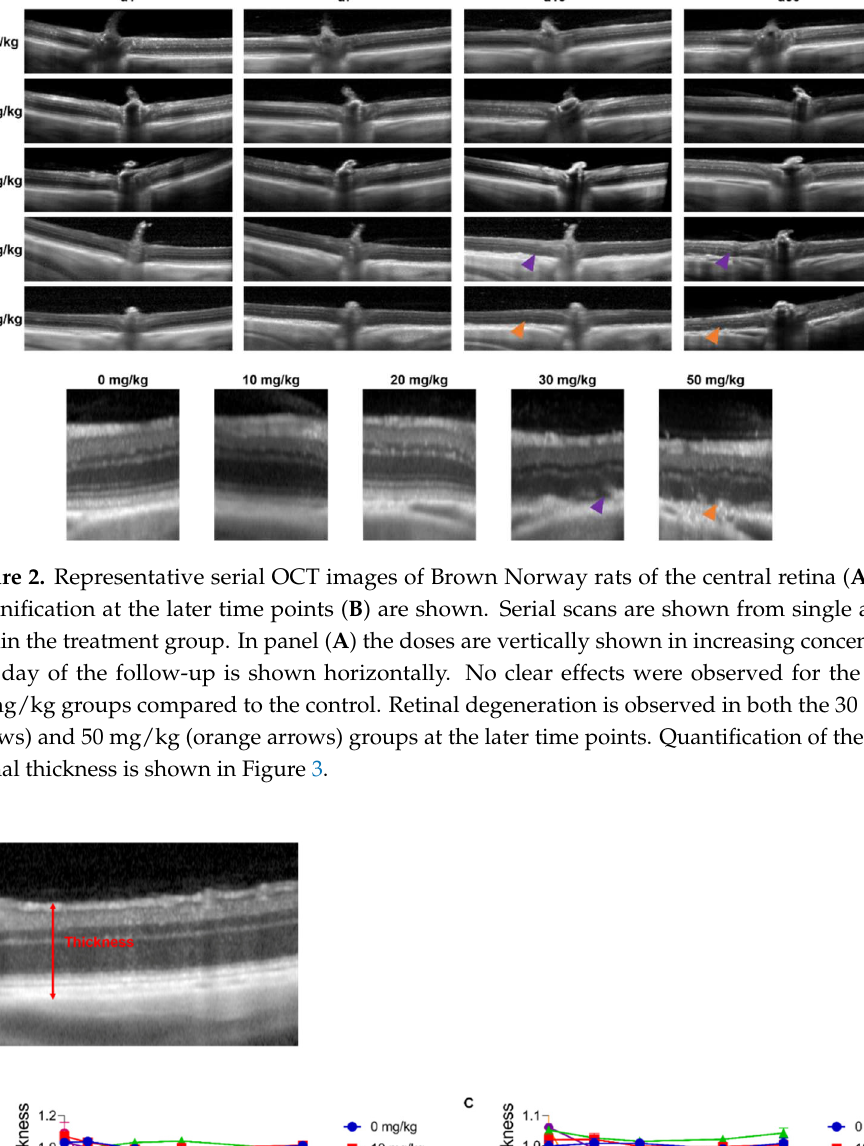
compared to the control. Retinal degenerations was observed in all other groups. This is also better visible in panel B, where the zoomed-in scans are shown per concentration SI (horizontally) and the later follow-up times (vertically). In the 30 mg/kg treatment group, retinal thinning started to show roughly 1 month post-injection (purple arrows). More drastic effects at the end of the experiments were observed for the 40 (pink arrows), 50 (orange arrows) and 70 mg/kg (lilac arrows) treatment groups. Quantification of the overall retinal thickness is shown in Figure 3.